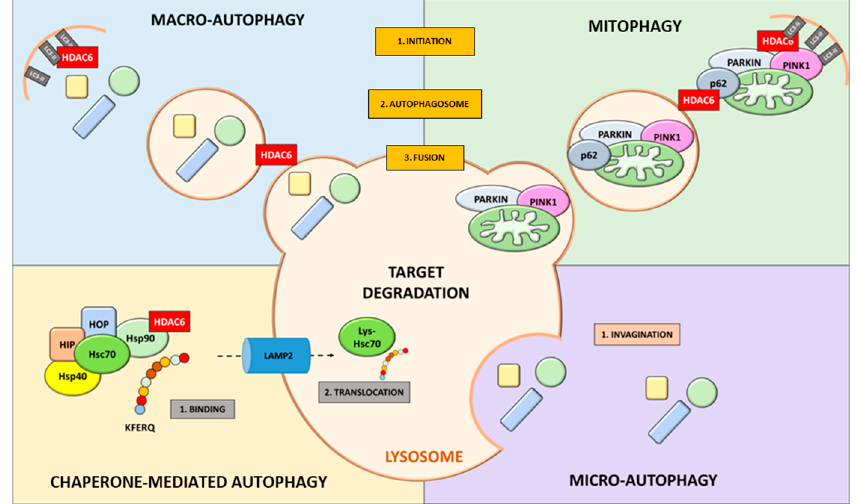
Figure 1. HDAC6 involvement in autophagy-related mechanisms.